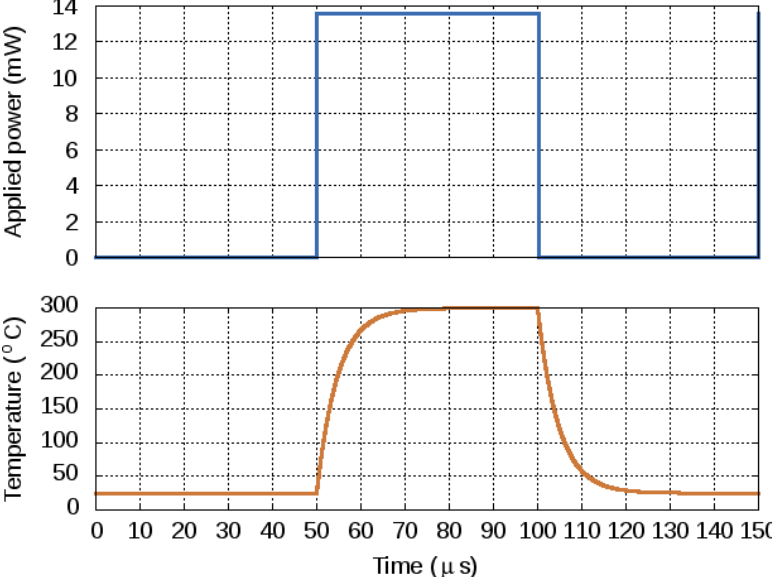
Figure 14. Cauer model reproduction of a microheater design presented in [17], which is further used to analyze the transient behavior of the heater.